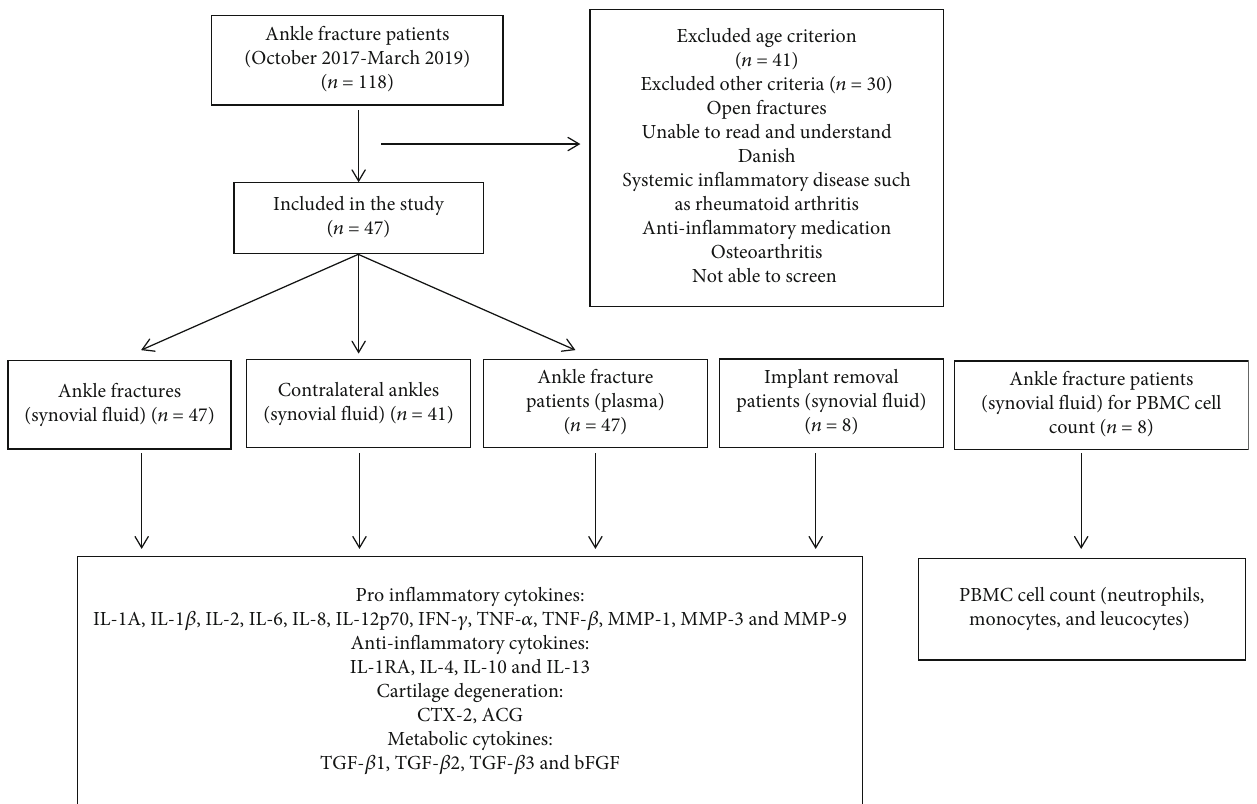
Figure 1: Flow diagram showing the study